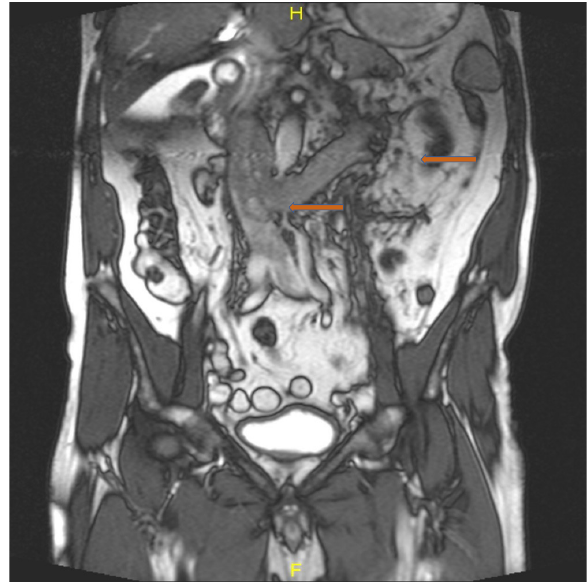
Figure 2: MRI of the abdomen and pelvis showing left renal mass, renal vein, and IVC